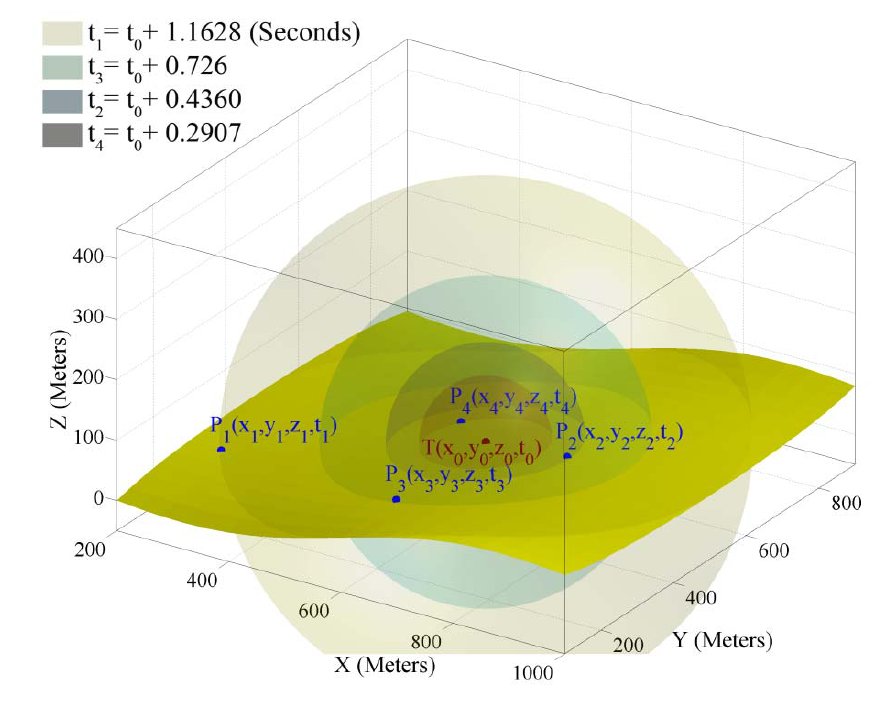
Figure 1. Basic schema of target localization in 3-dimensional